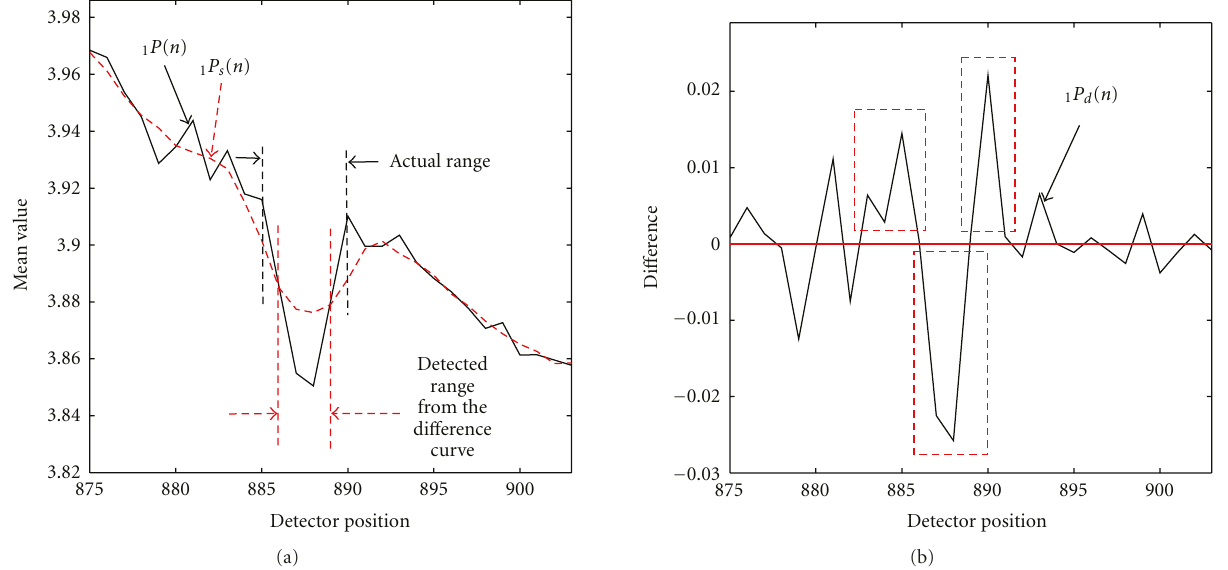
Figure 3: Detection of contiguous stripes using the mean curve. (a) A cropped mean curve and its smoothed version. (b) Di ff erence curve.